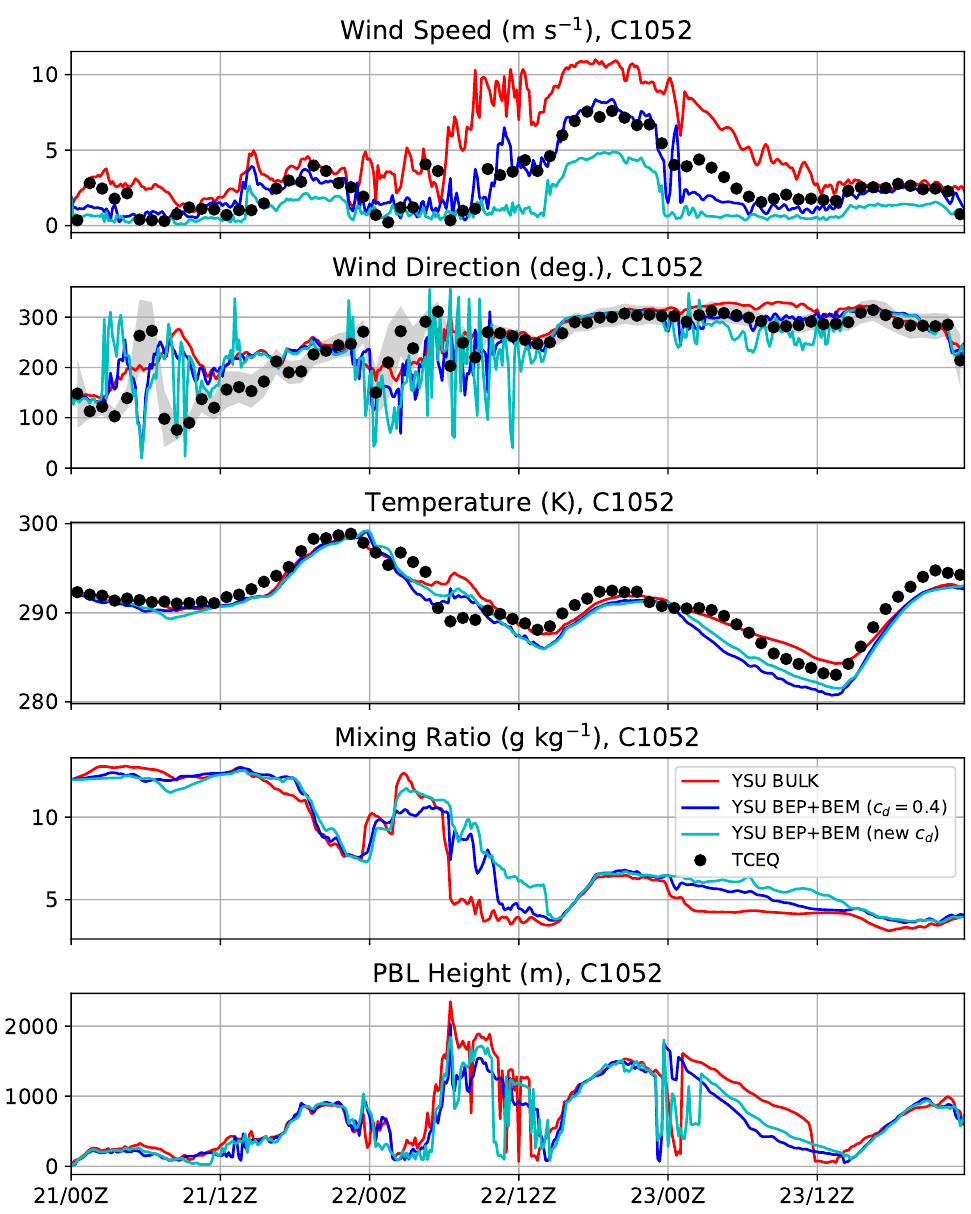
Figure 12. Same as Figure 7 but at COI station